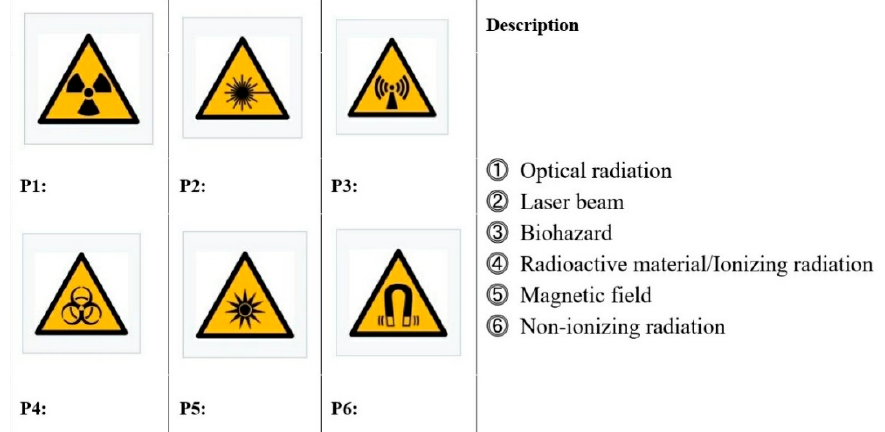
Figure 1. Item used to measure the recognition of pictograms related to radiation.